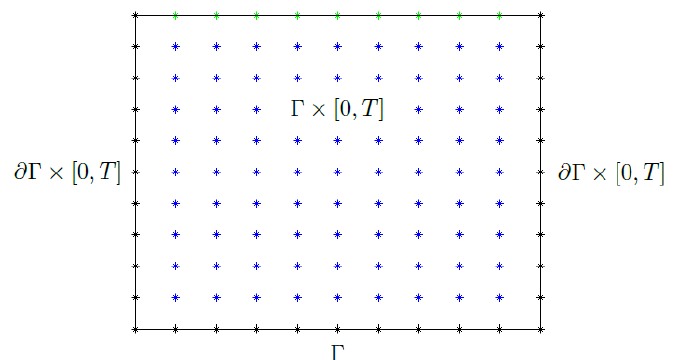
Figure 1. Computational domain of the problem, where the green nodes belongs to ∂ Γ × [ 0, T ] and Γ , and the blue nodes correspond to Γ × [ 0, T ] .The solution of the original problem corresponds to the solution at ∂ Γ × { t = T } (green nodes).